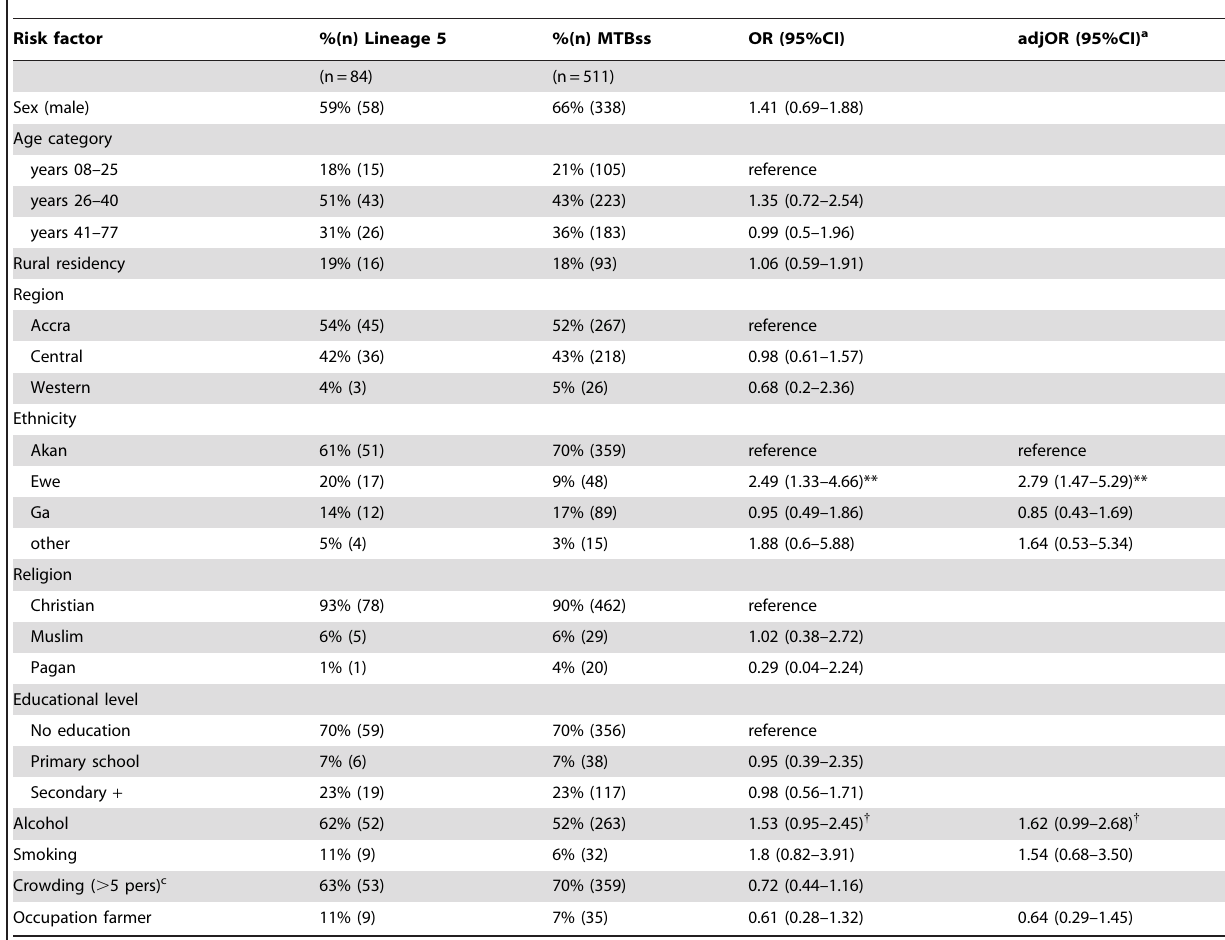
Table 4. Risk factors for Risk factor for TB caused by Lineage 5 compared to M. tuberculosis sensu